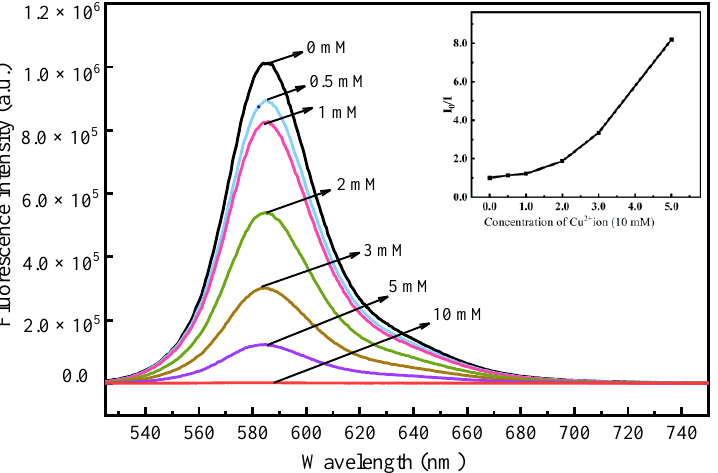
Figure 6. Fluorescence spectra of P(MMA-co-RB) in DMF solution (0.5 mg/mL) upon the addition of Cu 2+ ion (0, 0.5, 1, 2, 3, 5 and 10 mM, λ ex = 510 nm). Inset: fluorescence quenching efficiencies versus the concentrations of Cu 2+ ( λ em = 585 nm).